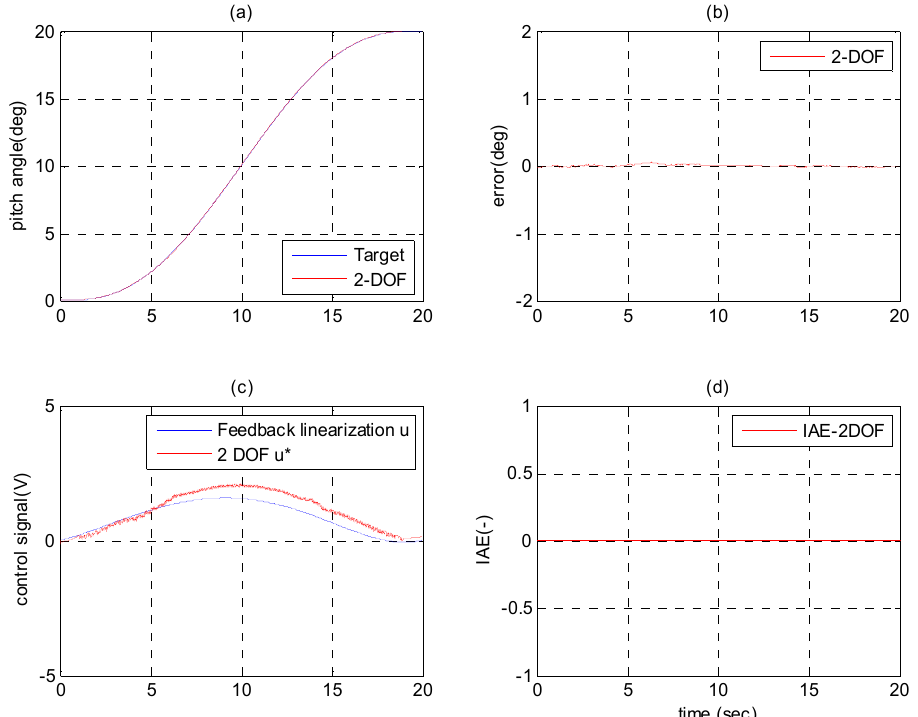
Figure 9. Experimental result of 5th order path ‐ positioning control of pitch angle with 2 ‐ DOF controller, stroke 20° in 20 sec with no load: ( a ) Pitch angle response; ( b ) Pitch angle error; ( c ) Comparison of control signals; ( d ) Integral of absolute error.